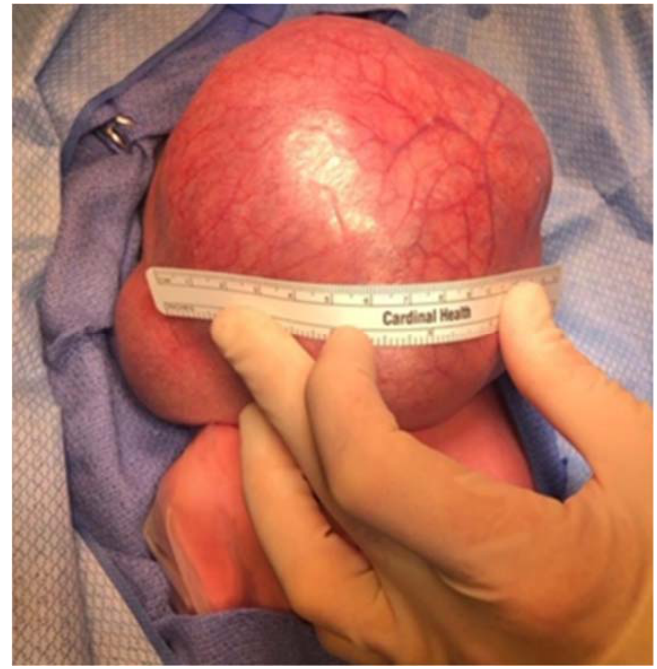
Figure 8. Infant with massive cervical teratoma. Infant was delivered via EXIT procedure with immediate mass resection following intubation while on maternal circulation.